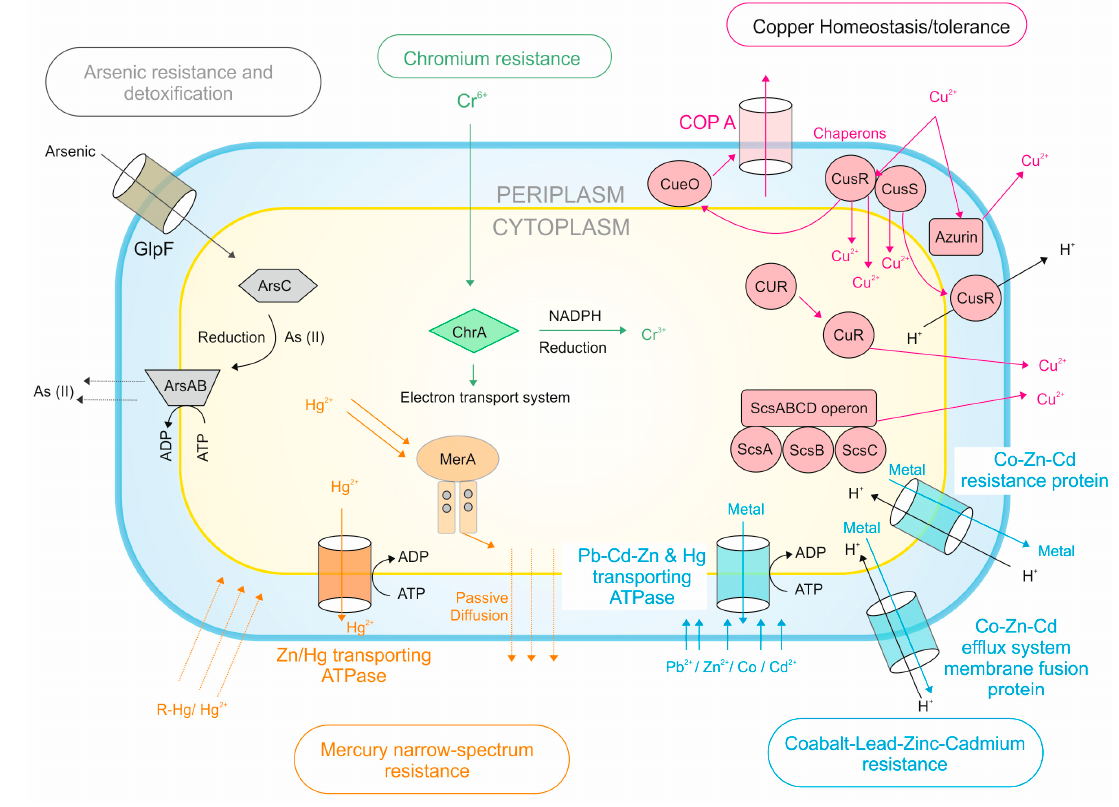
Figure 6. An overview for possible genes and pathways involved in heavy metal resistance in Salinivibrio sp. HTSP based on genome analysis.